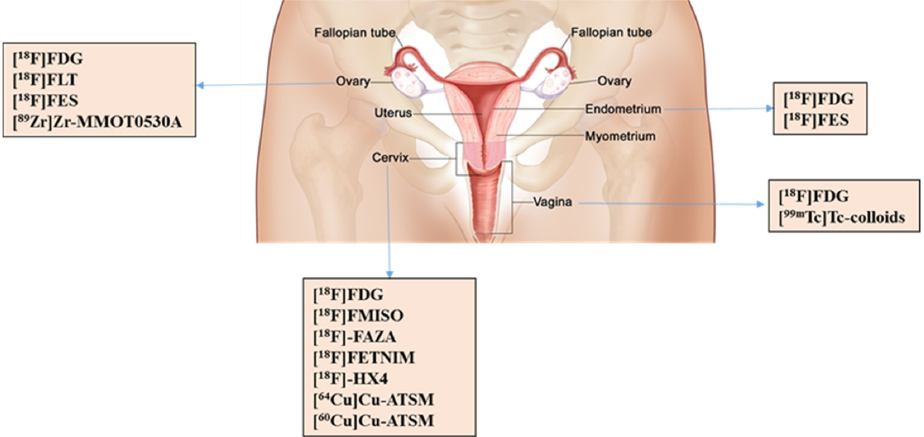
Figure 1. List of commonly applied radiopharmaceuticals in